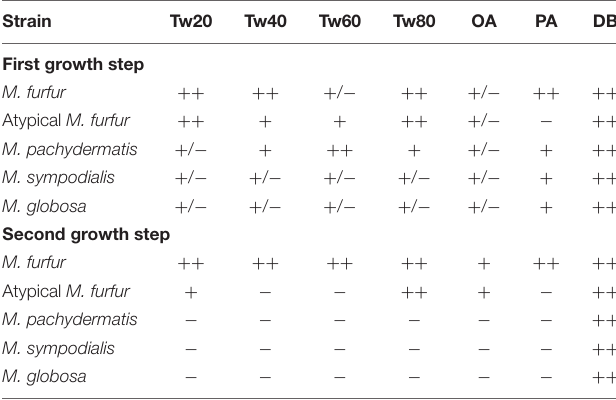
TABLE 6 | Physiological characterization of Malassezia spp. by culturing in liquid minimal medium (MM) containing either Tw20 (Tween 20), Tw40 (Tween 40),